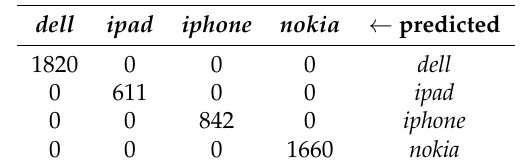
Table 12. Confusion matrix for neural networks using the optimized configuration settings, α = 0.1, 500 epochs, HLsigmoid =